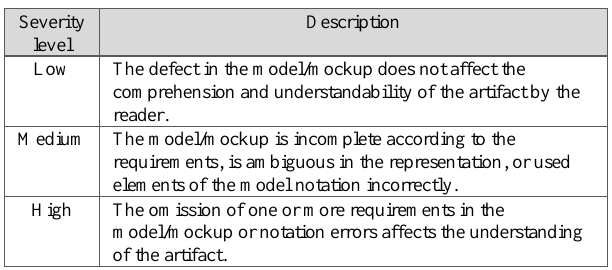
TABLE V. D EFECT SEVERITY LEVELS .